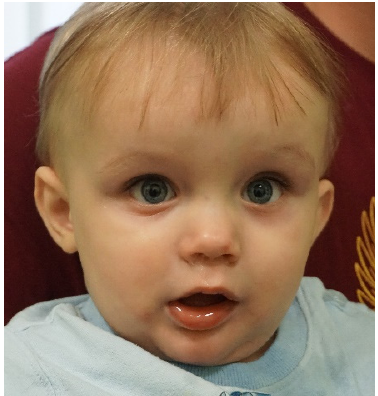
Figure 1. The child with Joubert syndrome.